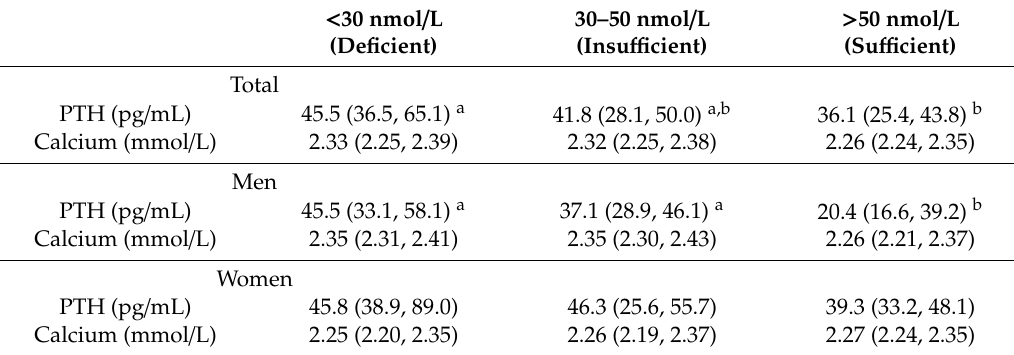
Figure 4. Vitamin D status of the population during the high vitamin D synthesis period (April to September) sub-divided by age group. Table 2. Bone marker concentrations of the participants by 25(OH)D status 1 .